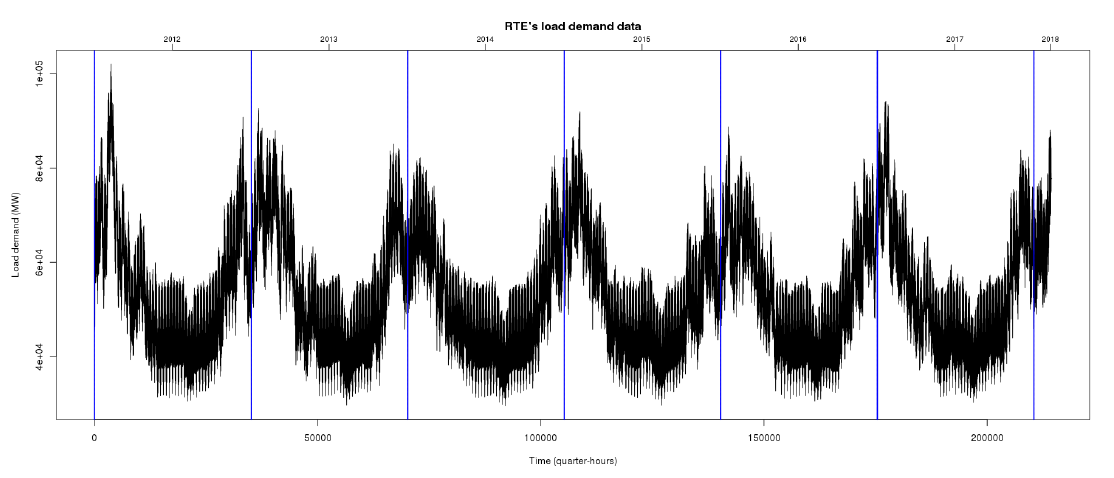
Figure 8. Daily load demand for France’s electricity grid from 2012 to 2018.